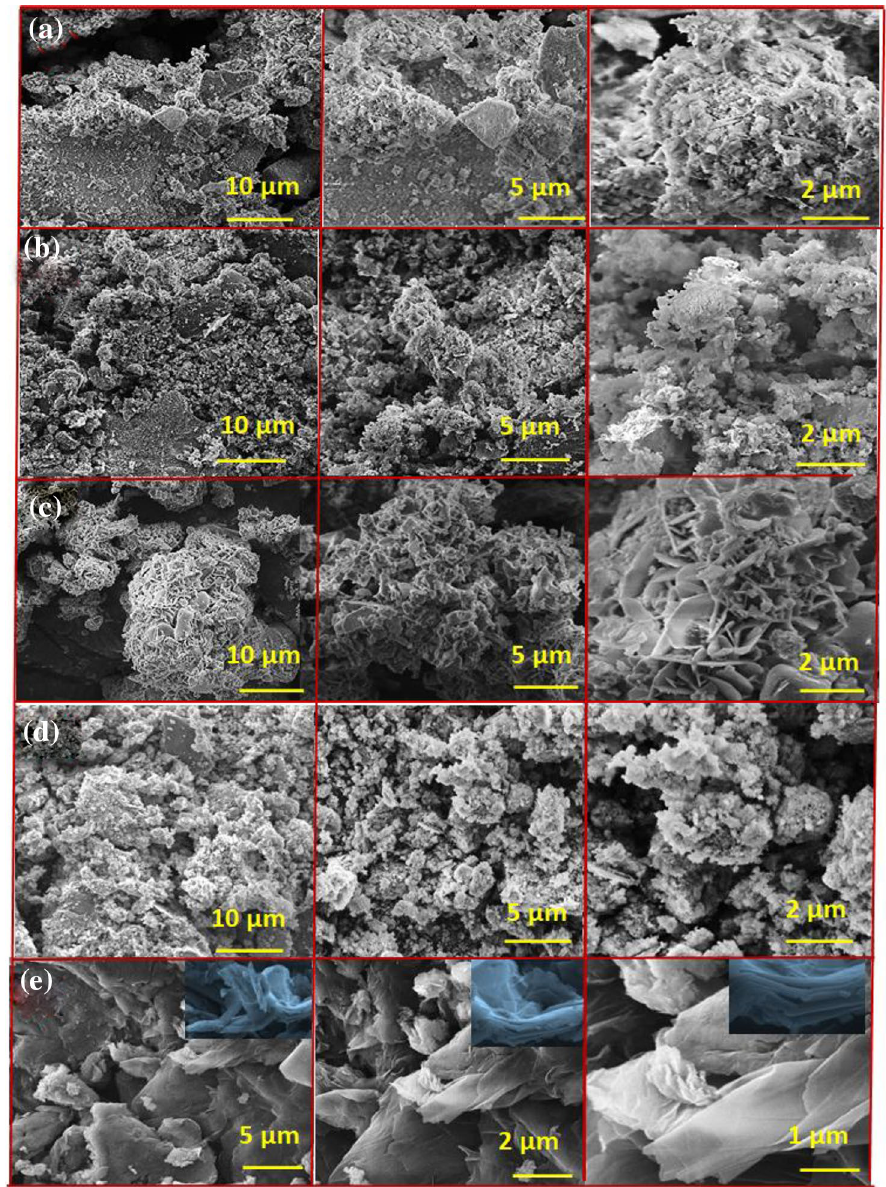
Figure 14. SEM images of ( a ) BG, ( b ) BG/GO, ( c ) BG (Na-free), ( d ) BG (Na-free)/GO, and ( e )